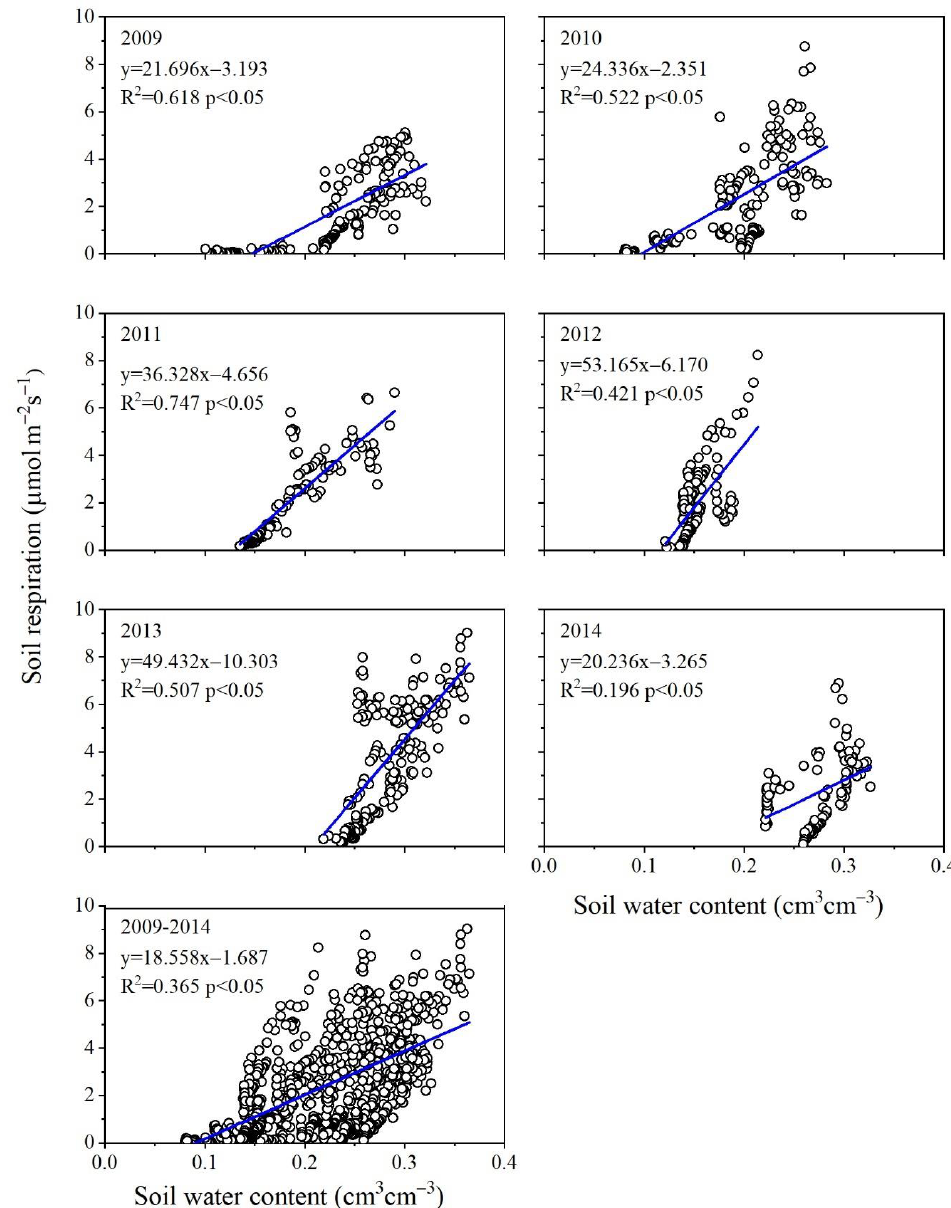
Figure 3. Relationships between soil respiration and soil moisture at 10 cm depth during 2009 –